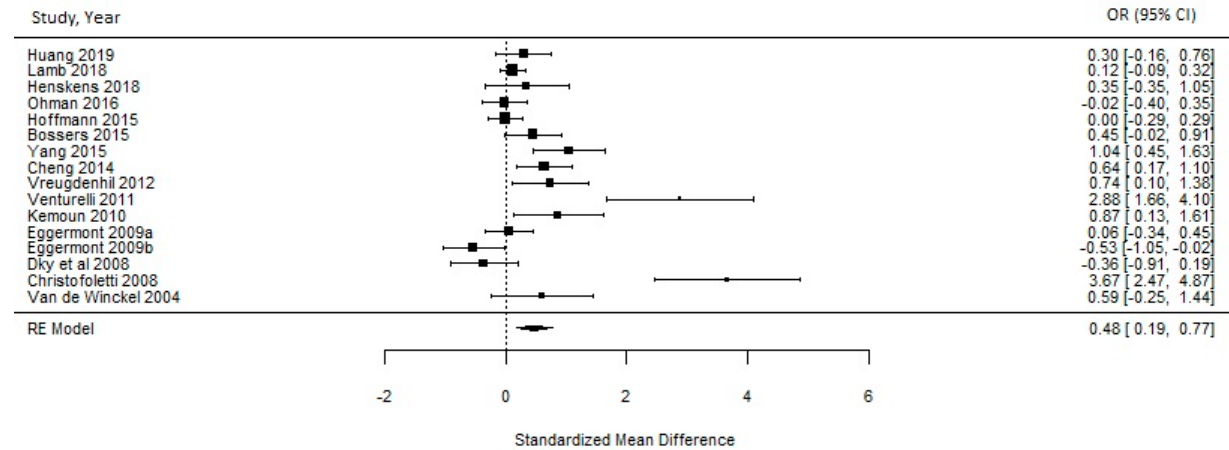
Figure 2. Effects of PA on the cognitive function of PwD.